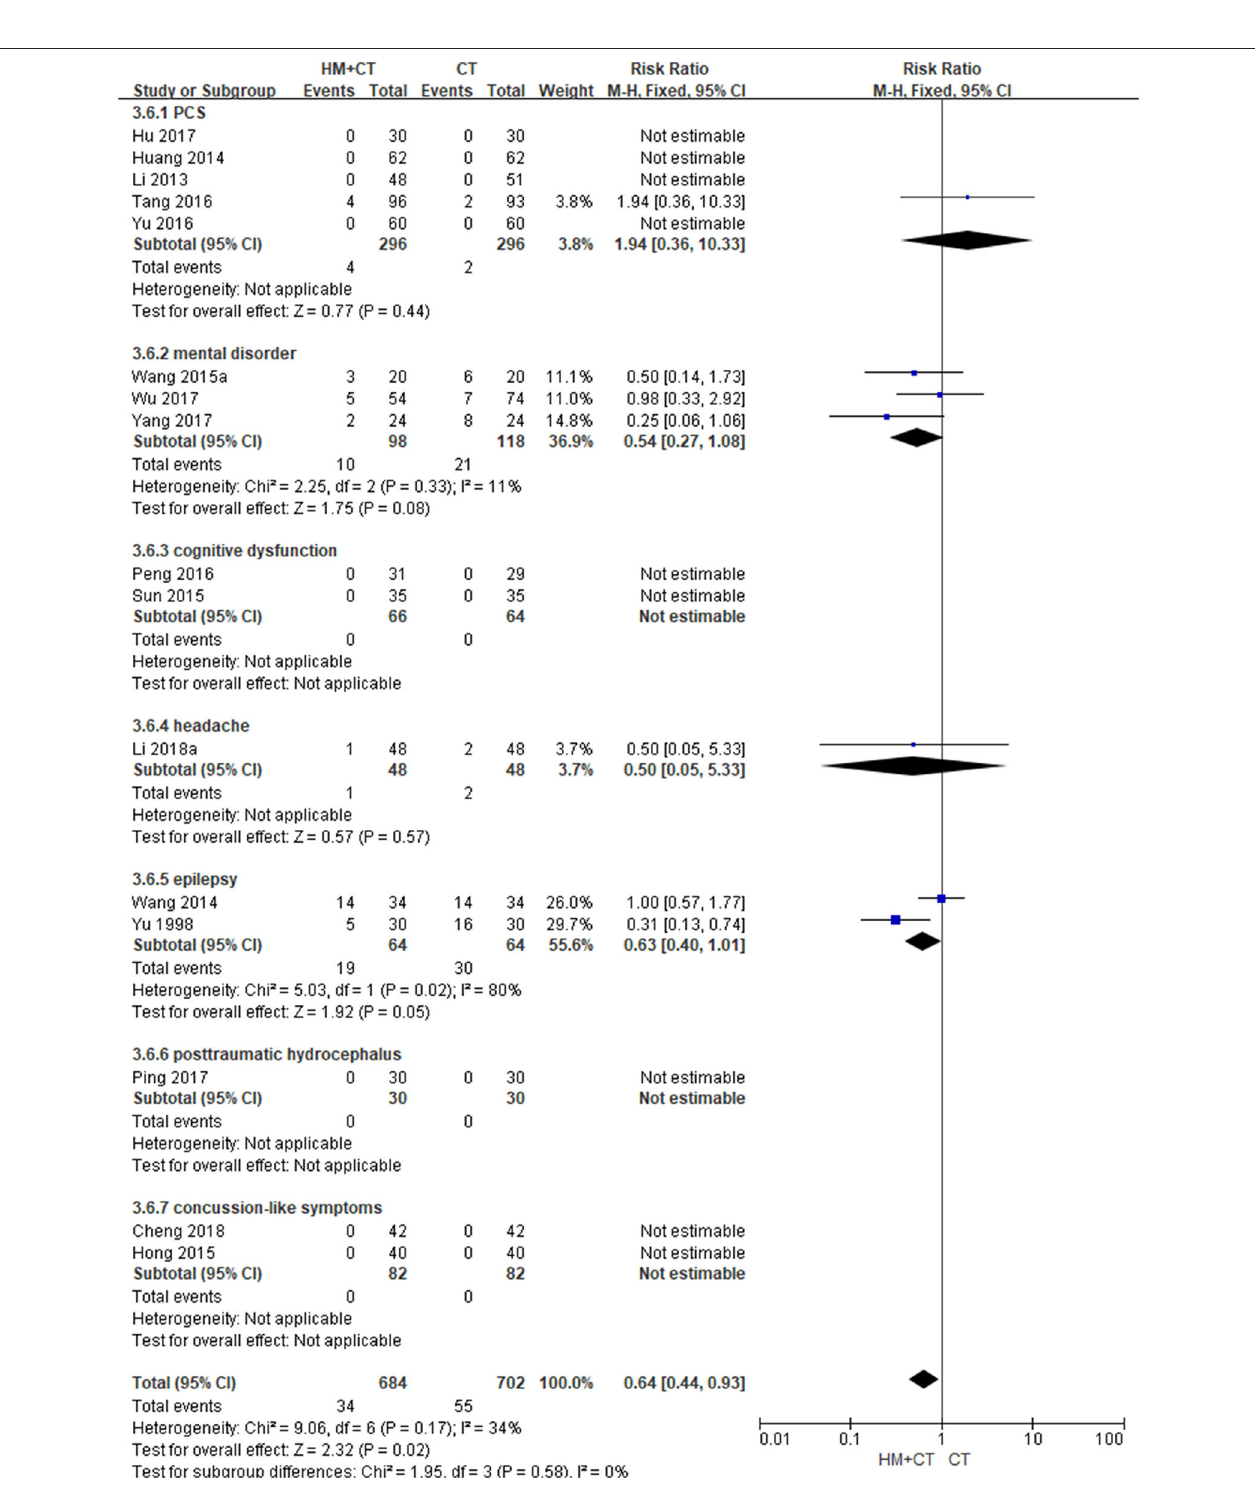
FIGURE 6 | Adverse event (Comparison of herbal medicine combined with conventional treatment vs. conventional treatment alone).